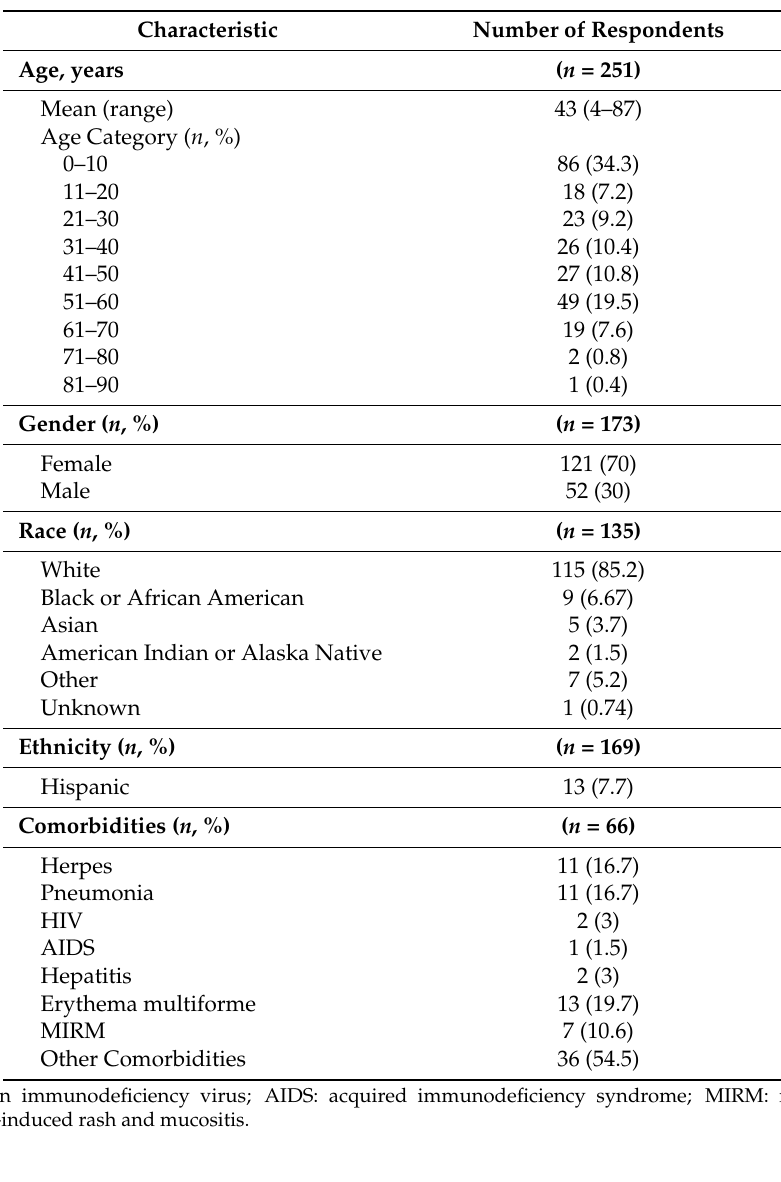
Table 2. Summary of respondent demographics.